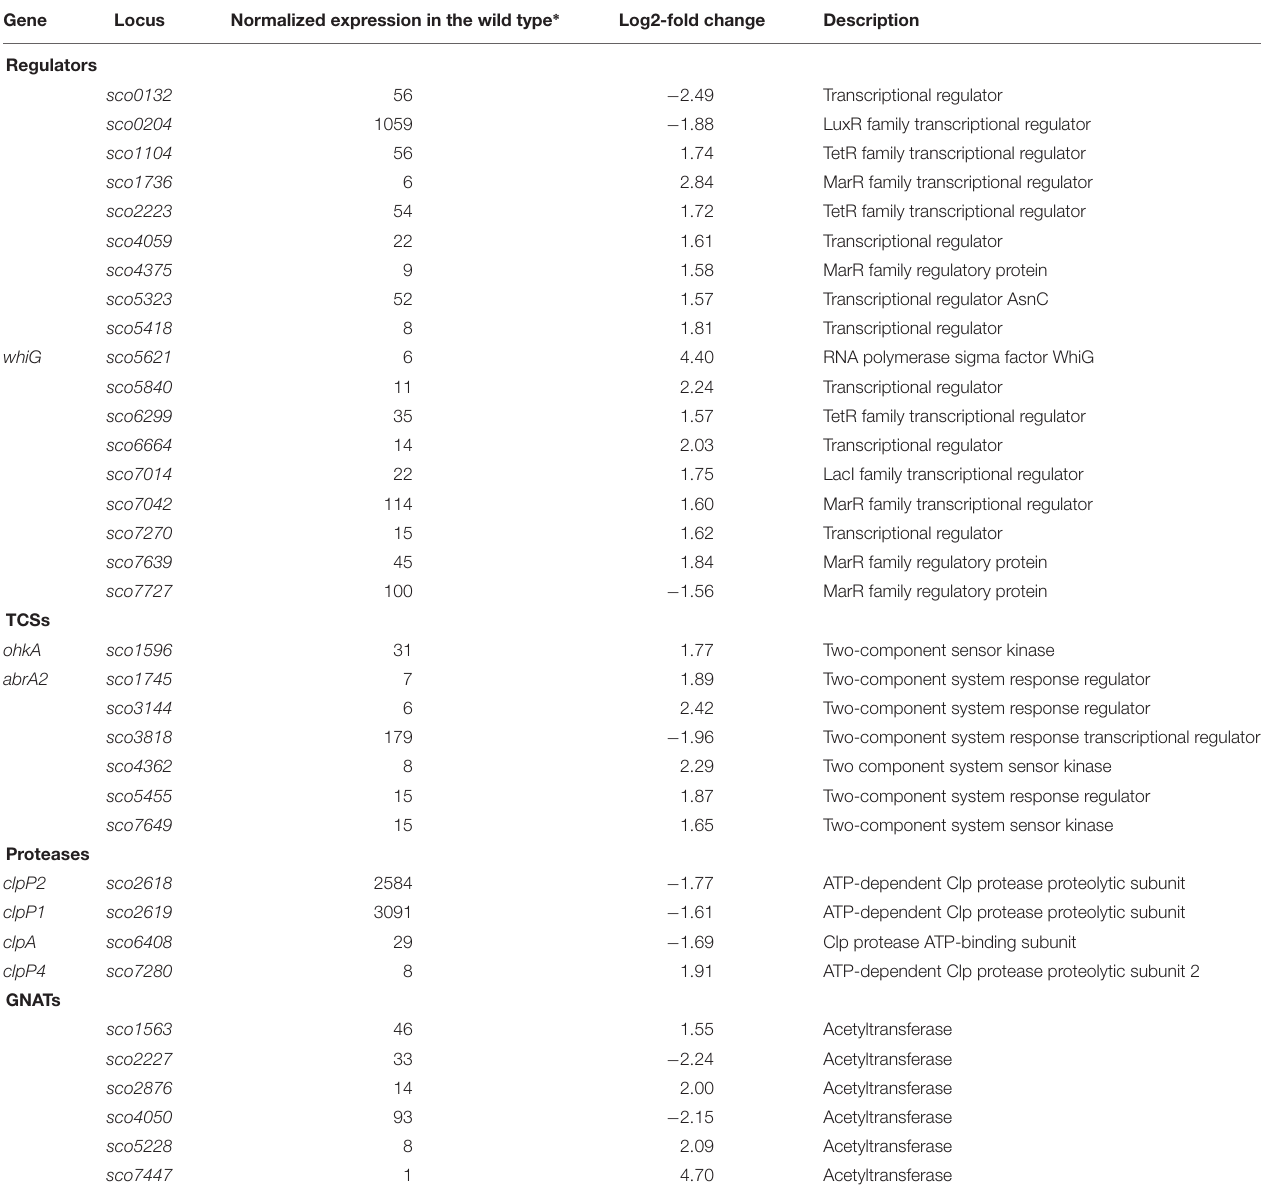
TABLE 8 | Regulatory genes affected by topA -downregulation (based on RNA-Seq data; log2-fold > 1.5; p < 0.05). Gene Locus Normalized expression in the wild type ∗ Log2-fold